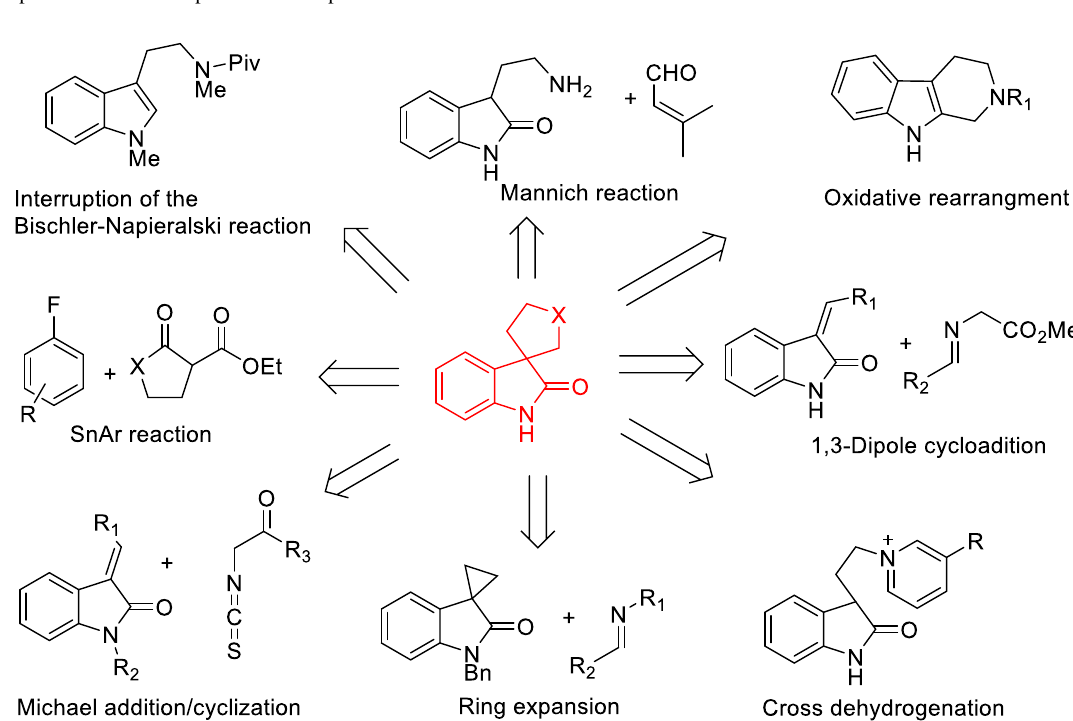
Fig. 1 Representative natural products with spirooxindole